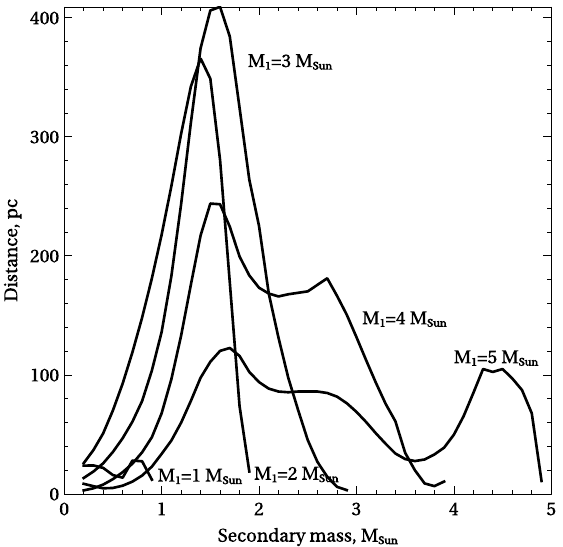
Fig. 4. Critical distance of binary detection as a function of the secondary mass for primary masses M 1 = 1, 2, 3, 4 and 5 M ⊙